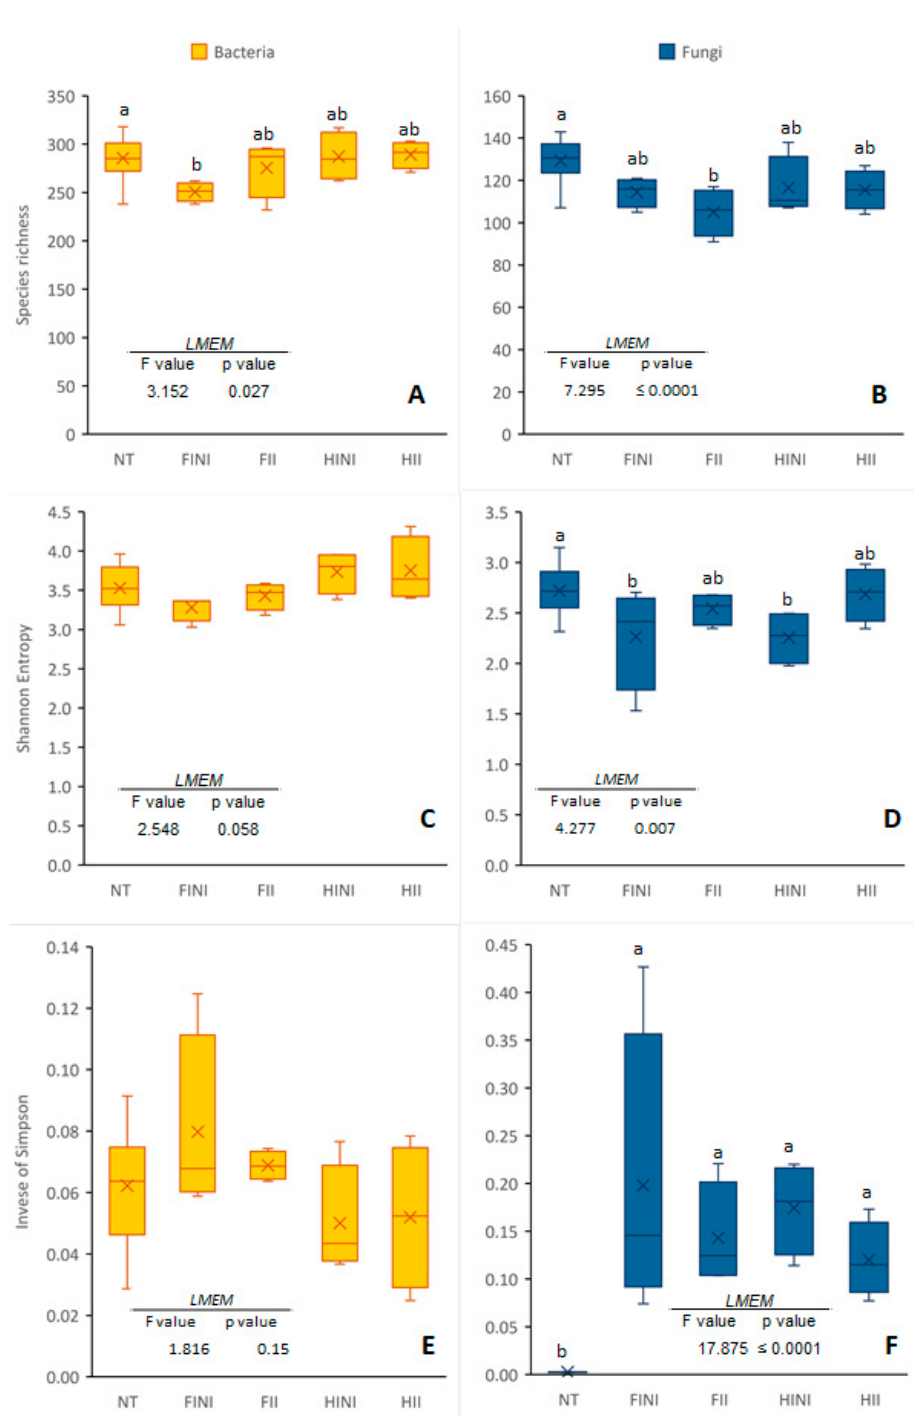
Figure 1. Species richness ( A , B ), Shannon diversity ( C , D ), and inverse of Simpson ( E , F ) indices of bacterial and fungal communities found in plots before (NT) and after treatments, different irrigation amounts (FI, fully irrigated, or HI, half irrigated), and AMF inoculation (I, inoculated, or NI, non-inoculated). Values represent means ± SE (n = 4–16), separated by the Kenward–Roger method and Tukey’s p -value adjustment ( p ≤ 0.05). Different letters indicate significant differences, as affected by NT or treatment application (FINI, FII, HINI, or HII), according to the linear mixed-effect model.